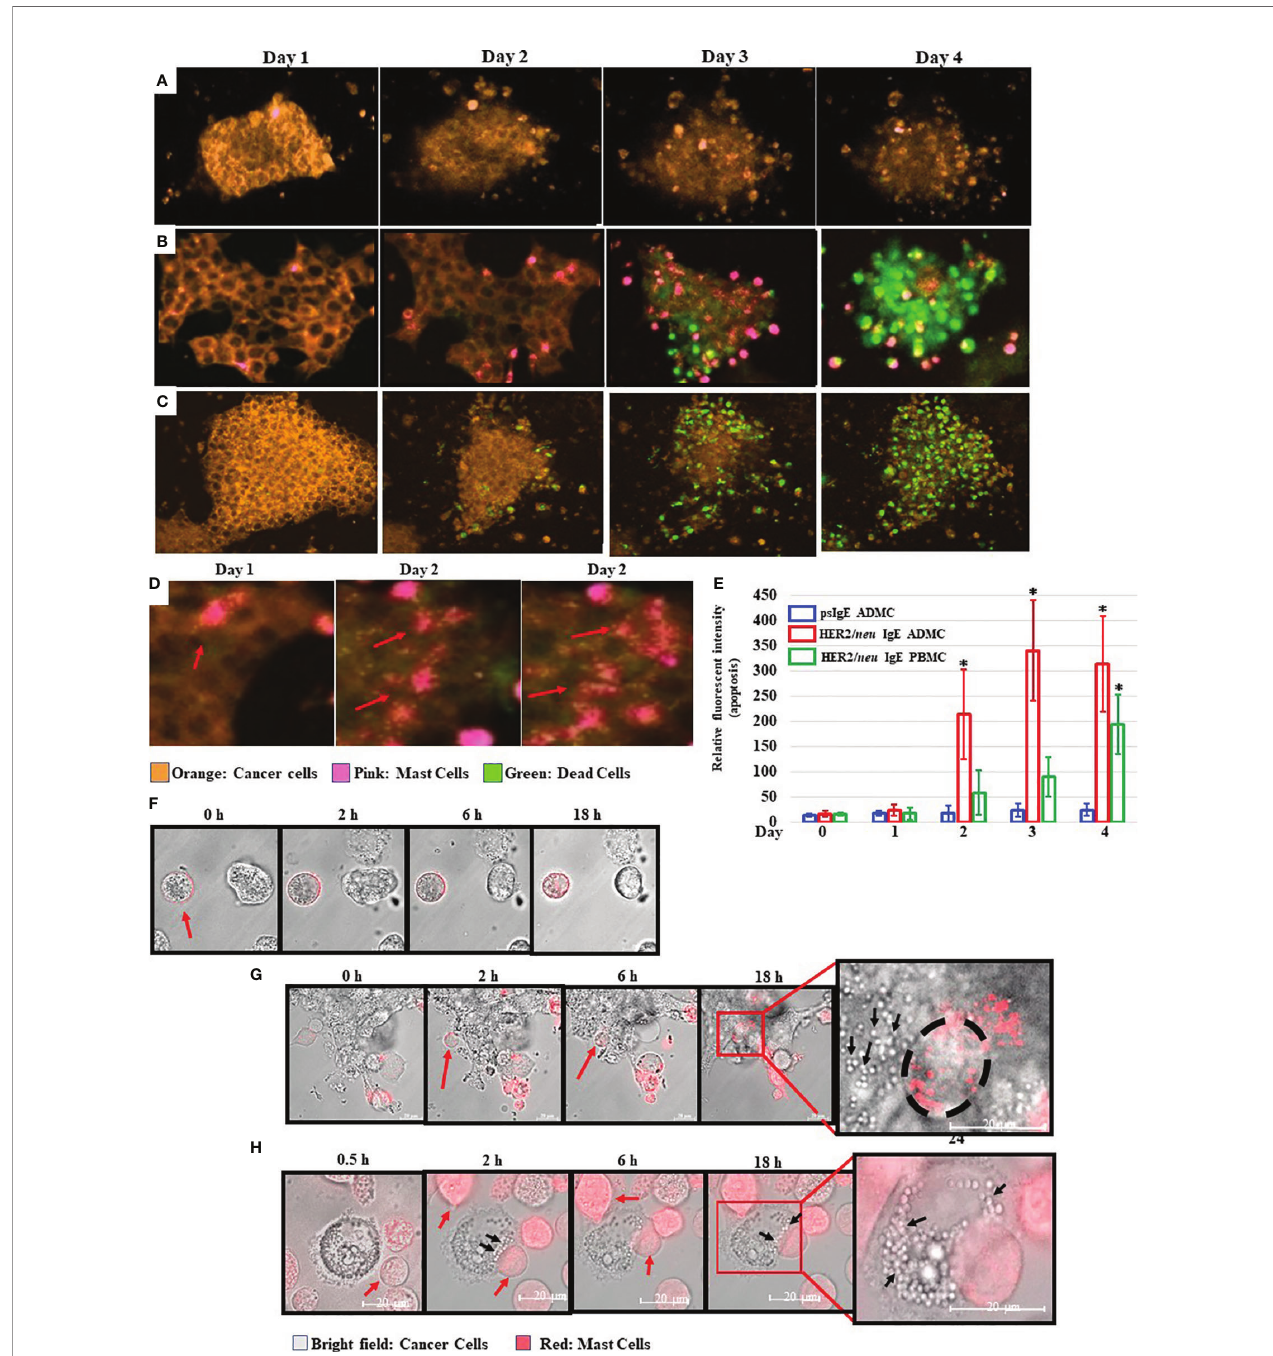
FIGURE 3 | Mast cells bind to, penetrate, degranulate, and induce Fc e RI-dependent apoptosis of BC cells. CellTracker ™ -Deep Red labelled ADMC (A, B) or BDMC (C) (7.5x10 4 ) were sensitized with 1 m g/ml non-speci fi c IgE (A) or anti-HER2/ neu IgE (B, C) , washed, and incubated with MitoTracker ™ -Red HER2/ neu + BT474-1261 in culture medium containing a fl uorescent apoptosis detecting dye (CellEvent Caspase 3/7; 1:100). Cells were monitored in a live cell chamber attached to a confocal microscope for up to 4 days. (D) . The amount of fl uorescent intensity of the apoptosis dye was quanti fi ed using Image J of the average of ten fi elds of view at 63x magni fi cation (±SD, *P < 0.05) (E) . Higher magni fi cations of several degranulating MCs is shown to illustrate the release and spreading of MC granules upon cancer cell HER2/ neu -induced activation of Fc e RI. The red arrows indicate spreading MC granules within the BT474-1261 cancer cell mass. (F – H) . MitoTracker ™ -Red labelled MCs (7.5x10 4 ) were sensitized with 1 m g/ml non-speci fi c IgE (F) or anti-HER2/ neu IgE (G, H) , washed, and incubated with HER2/ neu + BT474-1261 (F, G) or SK-BR-3 (H) cells and monitored in a live cell chamber for the indicated times. The red arrows indicate the dye-labelled ADMC, black arrows indicate cancer cell apoptotic bodies, and black circle indicates the outline of the ADMC within the tumor cell mass. Experiments are representative of 3 different